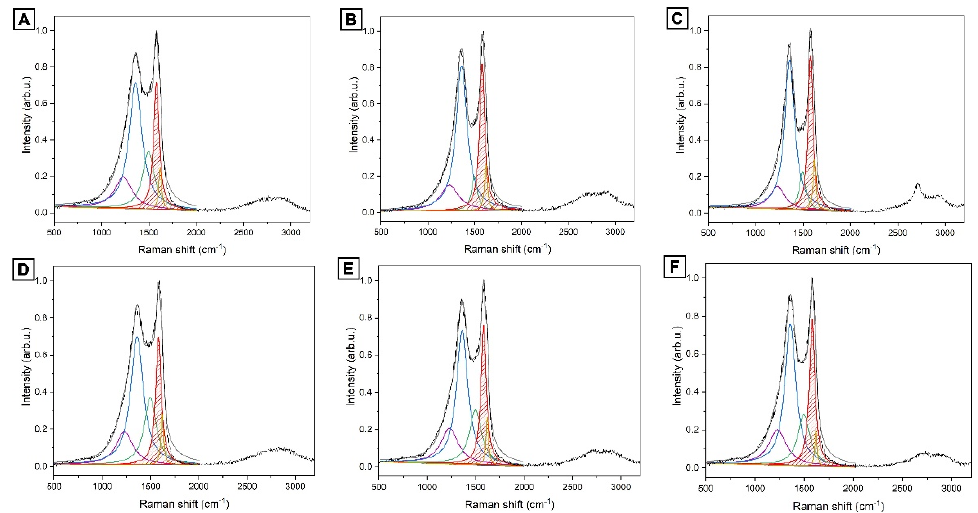
Figure 2. Raman spectra of a carbon material. ( A ) AKS-700 ◦ C; ( B ) AKS-800 ◦ C; ( C ) AKS-900 ◦ C; ( D ) APS-700 ◦ C; ( E ) APS-800 ◦ C; ( F ) APS-900 ◦ C. Degree of graphitization was calculated by the formula (3) [39]